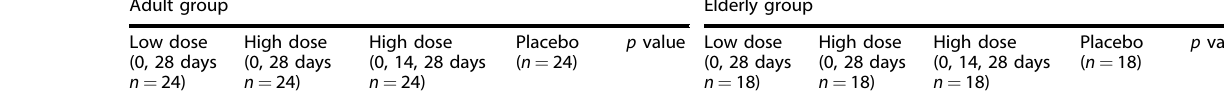
Table 4. Speci fi c antibody responses to RBD, neutralising antibodies to live SARS-CV-2 and pseudovirus post vaccination in phase 1